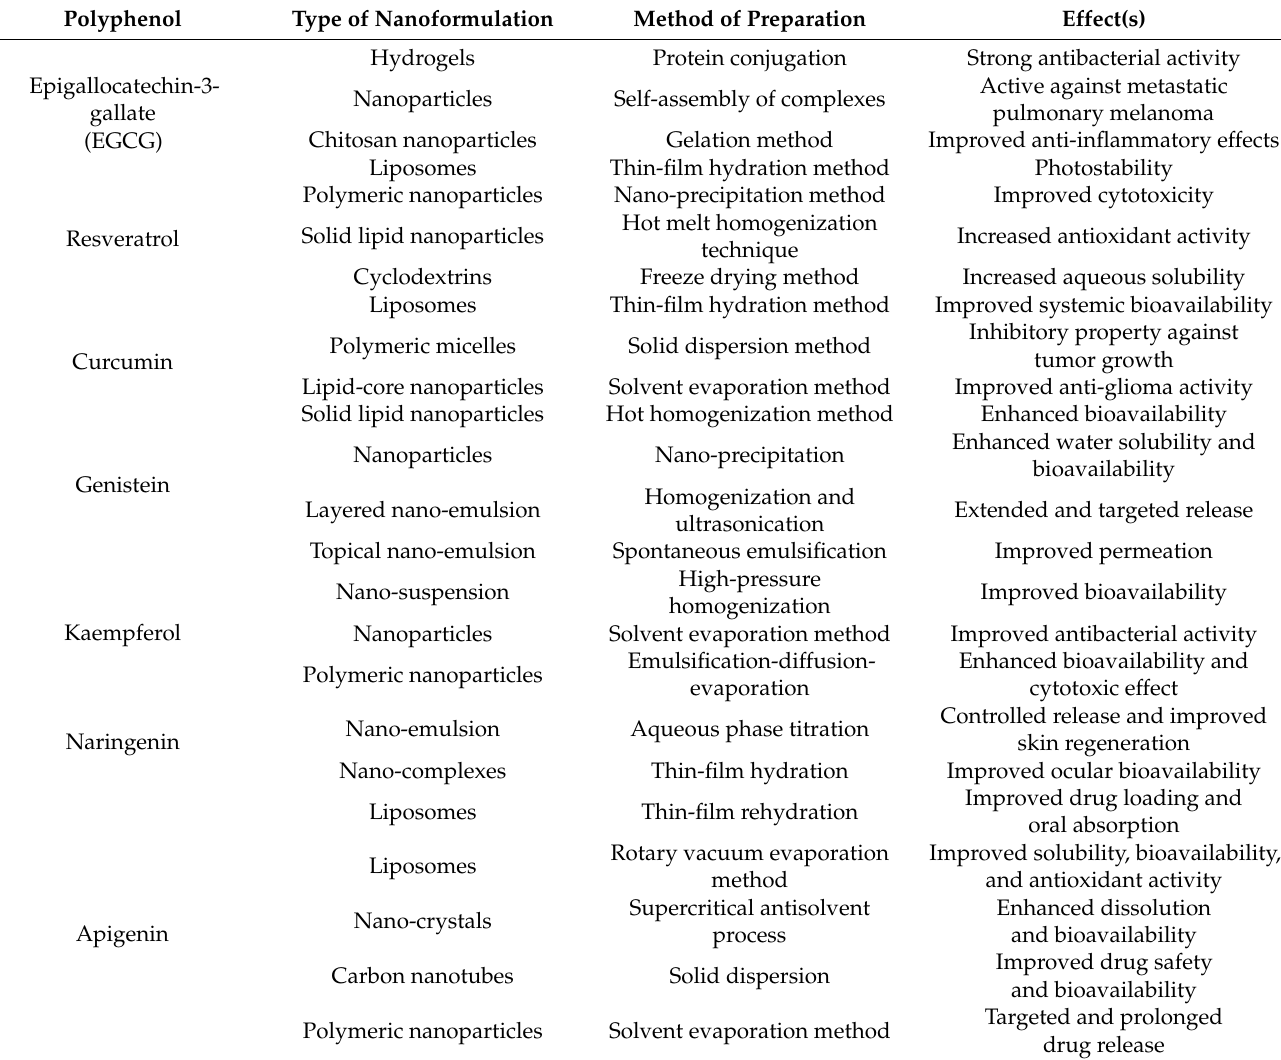
Table 1. Nanoformulation approaches designed for the delivery of dietary